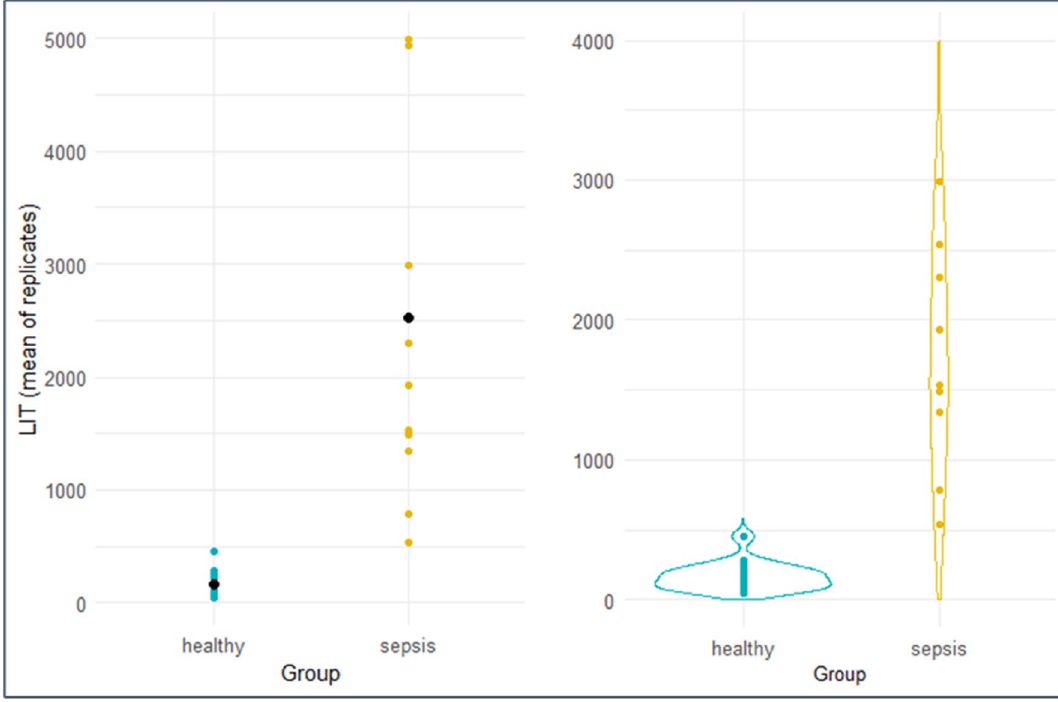
Figure 4. Dot plot (L) and violin plot (R) of LIT scores in patients with sepsis compared to healthy volunteers. Median LIT score for patients with sepsis was 2120 (IQR: 2024) and was > 13-fold higher than values within the control group (median: 153; IQR: 112, Mann–Whitney U test, p <